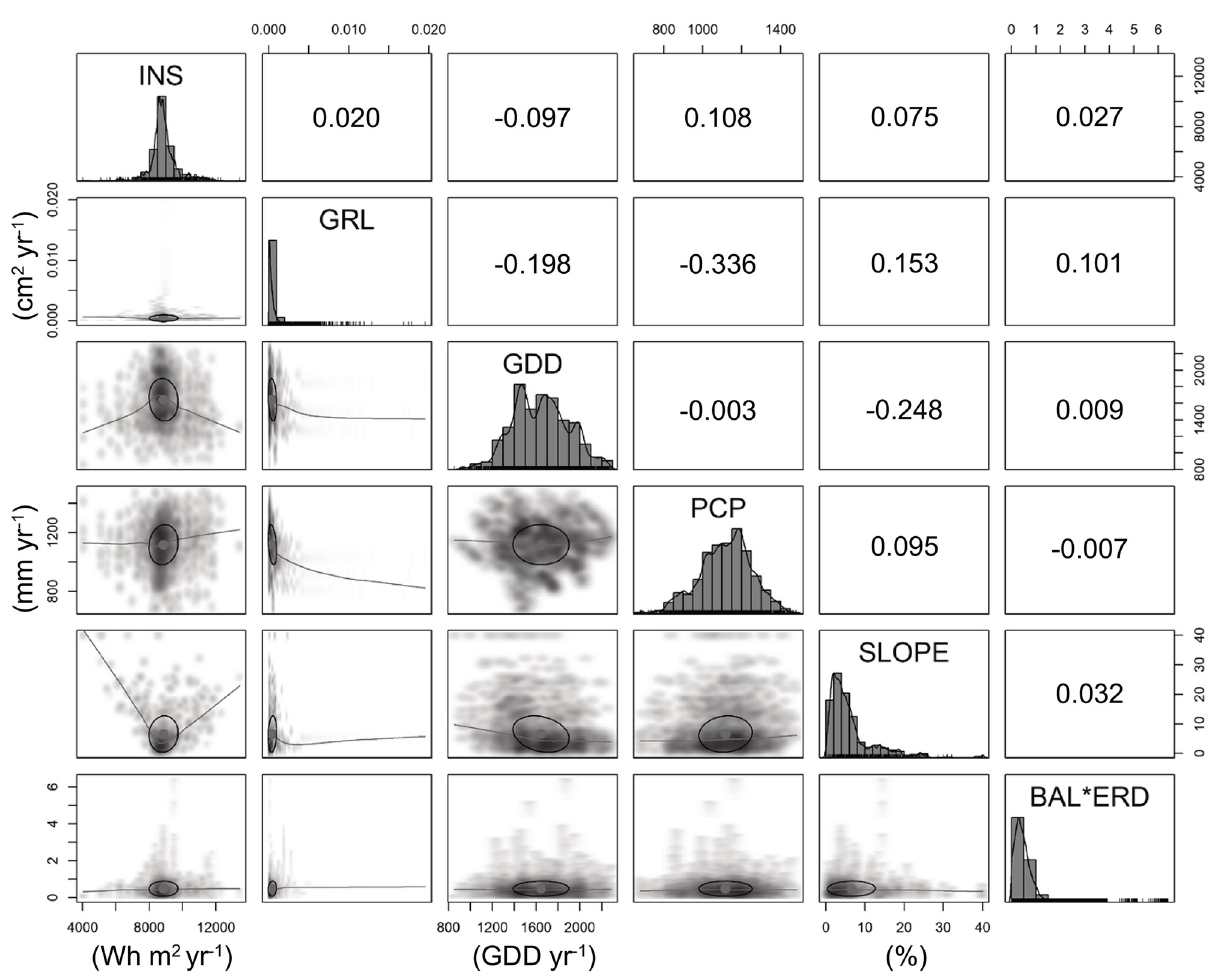
Fig 2. Correlation matrix for the nine independent variables used in the modeling methods. Variable distribution is shown along the diagonal, Spearman rank correlation between the corresponding independent variables in the upper right quadrant.